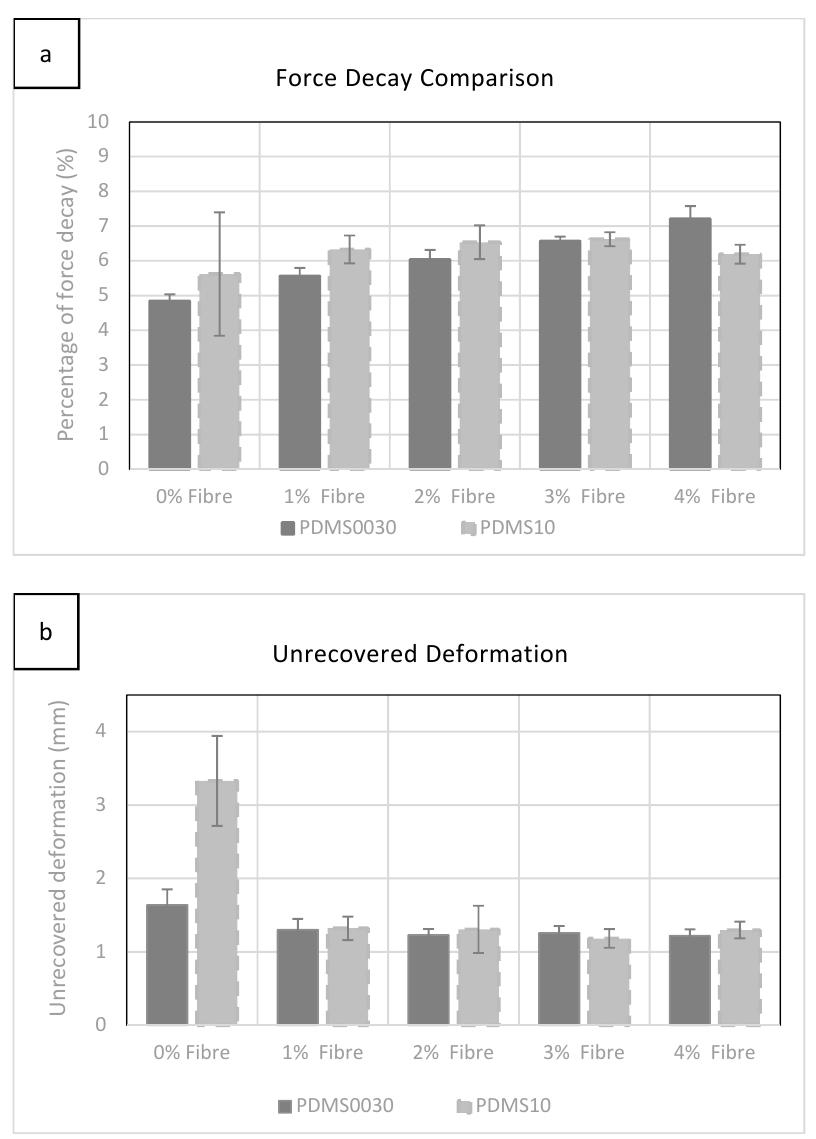
Figure 4. ( a ) Comparison of force decay of samples measured after 60 s on the 5th loading cycle. Figure 4a. Comparison of force decay of samples measured after 60 seconds on the 5 th loading cycle. The error bars represent the standard deviation in each group. The error bars represent the standard deviation in each group. ( b ) Comparison of the unrecovered Figure 4b. Comparison of the unrecovered deformation observed in all specimens after 60 seconds at 5N. The error deformation observed in all specimens after 60 s at 5 N. The error bars represent the standard deviation bars represent the standard deviation in each group. in each